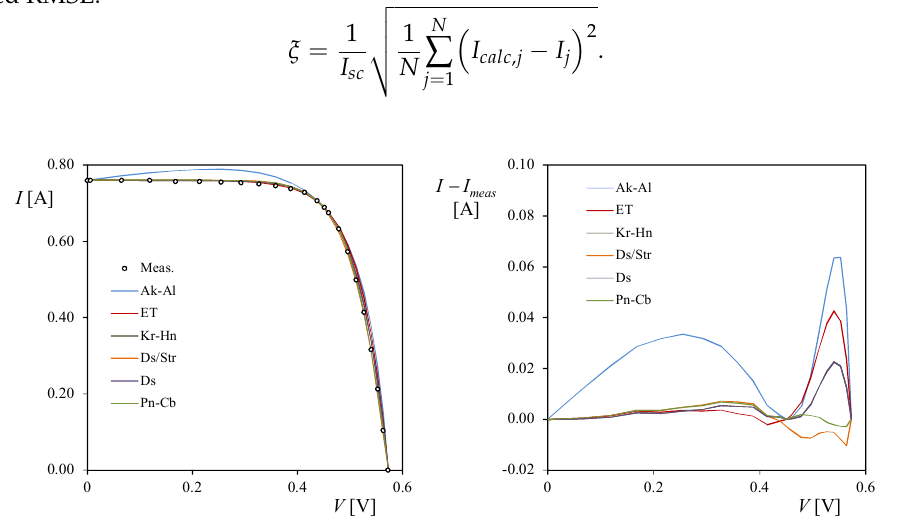
Figure 4. Curves for the explicit models analyzed, fitted to the RTC France solar cell data using the analytical methods proposed; see Section 2 ( left ). The error in relation to the data is also included in the figure ( right ).